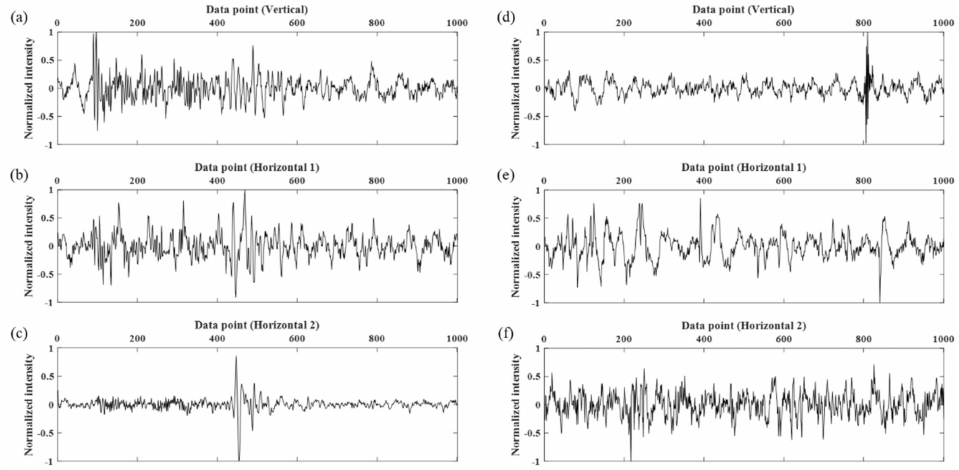
Figure 13. False noise and false signal of the test set from ( a – c ) RF and ( d – f ) CNN, respectively. It is hypothesized that the RF-trained model confused signal as noise because of the amplitude fluctuation pattern of the vertical component. The energy of the vertical component in Figure 13a is weak compared to the ambient noise level. For the CNN model case, we found that the overall amplitude fluctuation pattern of the vertical component from the noise samples is similar except for that of sample number 19, which has an abrupt elevation in amplitude at the end of the data points (Figure 13d). This implies that